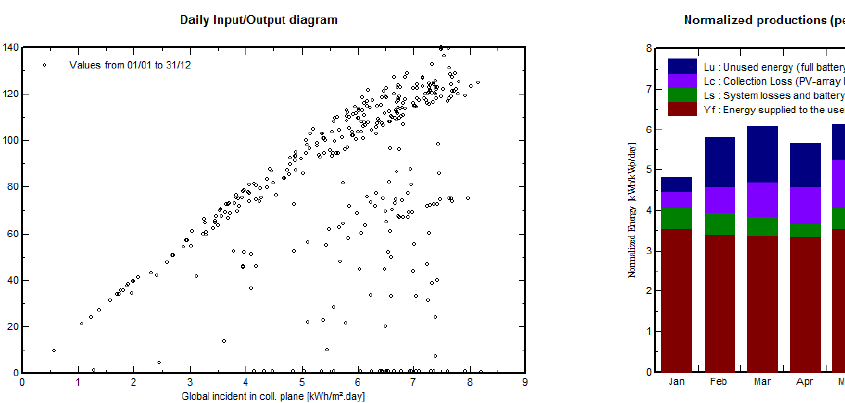
Figure 6. Daily generated power. Figure 7. Normalized